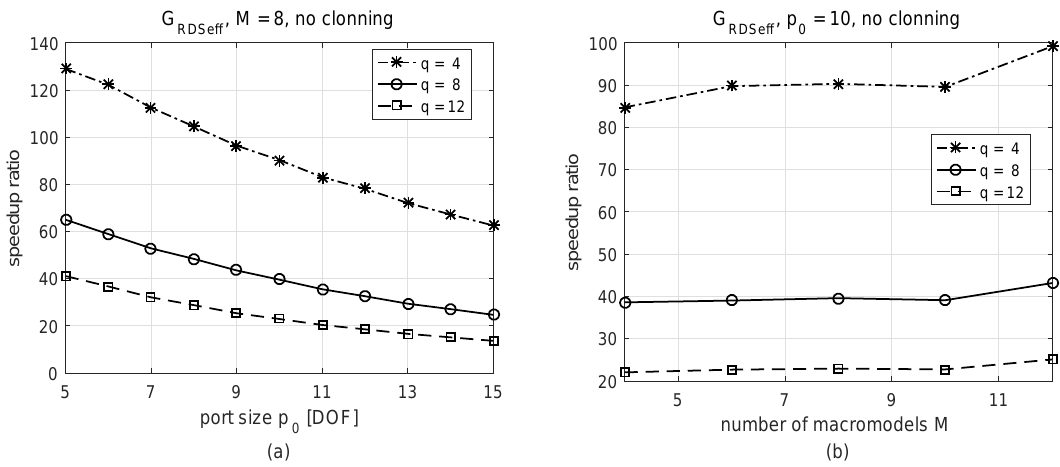
Figure 10. Effective gain of MOR and diagonalization G RDSeff , without cloning: versus port size p 0 for M = 8 ( a ); and versus number of macromodels M for p 0 = 10 ( b